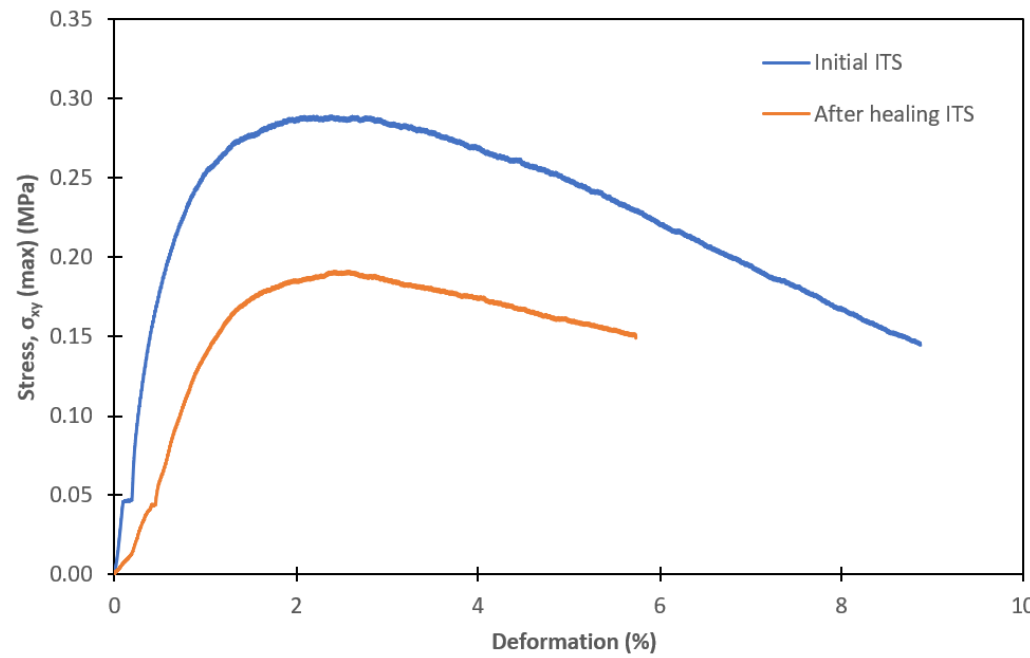
Processes 2021 , 9 , x FOR PEER REVIEW